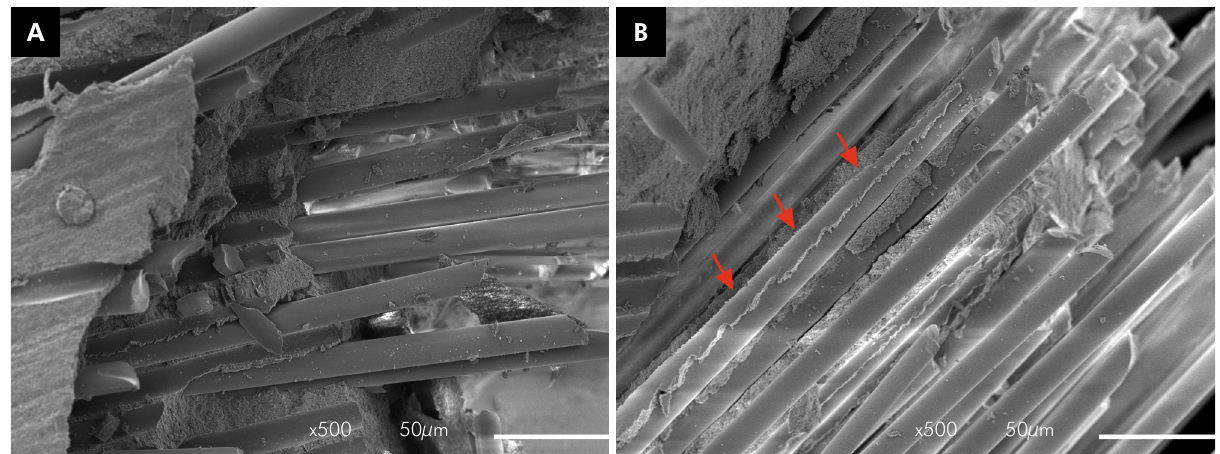
(A) At 500×, the P group revealed some remnants of the resin matrix at the fiber surfaces. (B) At 500×, the PH-P group revealed resins in intimate contact with glass fibers (arrows). Figure 6. SEM analysis revealing the interaction between the fibers and resin matrix in groups that were or were not preheated.